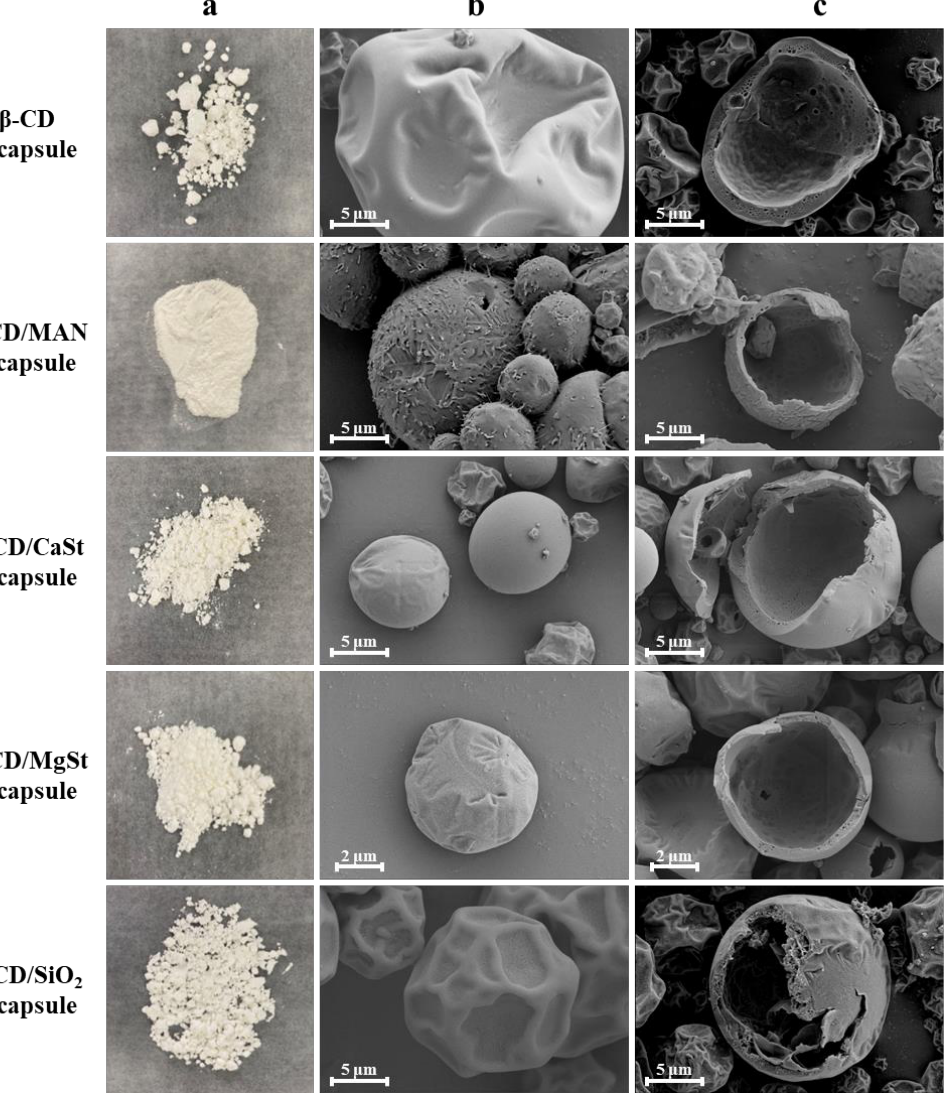
Figure 1. ( a ) Appearance, ( b ) surface morphology, and ( c ) internal structure of microcapsules with different anticaking agents.